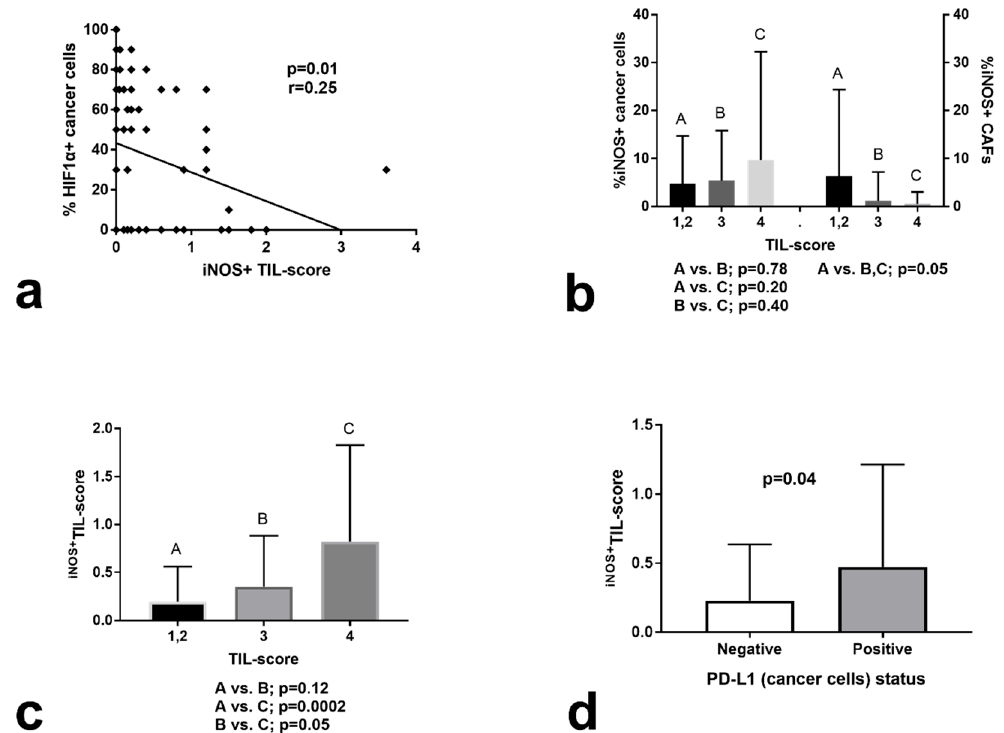
Figure 2. Statistical associations of iNOS expression: ( a ) Linear regression analysis of iNOS+ TIL score vs. the extent of Hypoxia-Inducible Factor 1 α (HIF1 α ) expression by cancer cells. ( b ) Percentage of iNOS+ cancer cells and extent of iNOS expression by Cancer-Associated Fibroblasts (CAFs) according to the TIL score. ( c ) Association between iNOS+ TIL score and TIL score. ( d ) iNOS+ TIL score in tumors with positive and negative PD-L1 cancer cell expression.